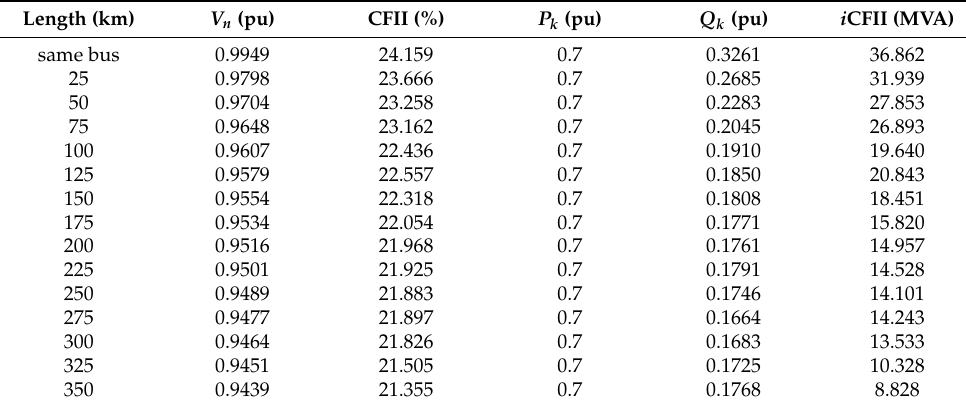
Table 4. Local CFII values in the h MIF system—line